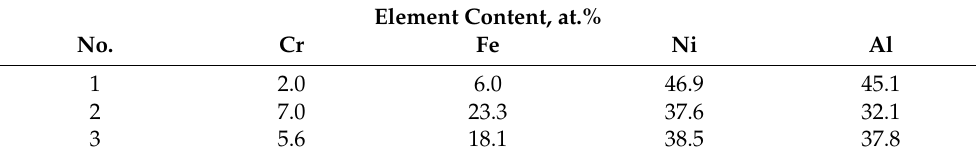
Figure 9. SEM image of the microstructure of the tube and sample interface in segment II: ( a ) ampoule No. 1; ( b ) ampoule No. 2. Table 3. EDS analysis results for ampoule No. 1 in according to each point marked in Figure 9a. Element Content,